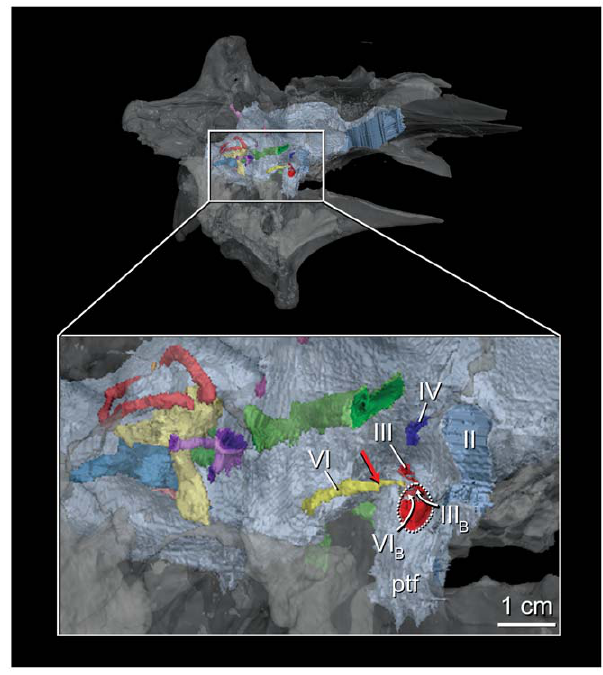
Figure 7. The diencephalic region of the braincase and endocranial cast of Alioramusaltai (IGM 100/1844). The braincase is rendered in right anteroventrolateral view shows the position of the sinus cavernosus. The red arrow shows the point at which the abducens nerve enters the pituitary fossa. Dotted line delimits the sinus cavernosus as expressed on the external surface of the braincase. II, optic canal; III oculomotor canal, III B , position of external opening of oculomotor canal within sinus cavernosus; IV, trochlear canal; VI, abducens canal; VI B , position of external opening of oculomotor canal within sinus cavernosus; ptf, pituitary